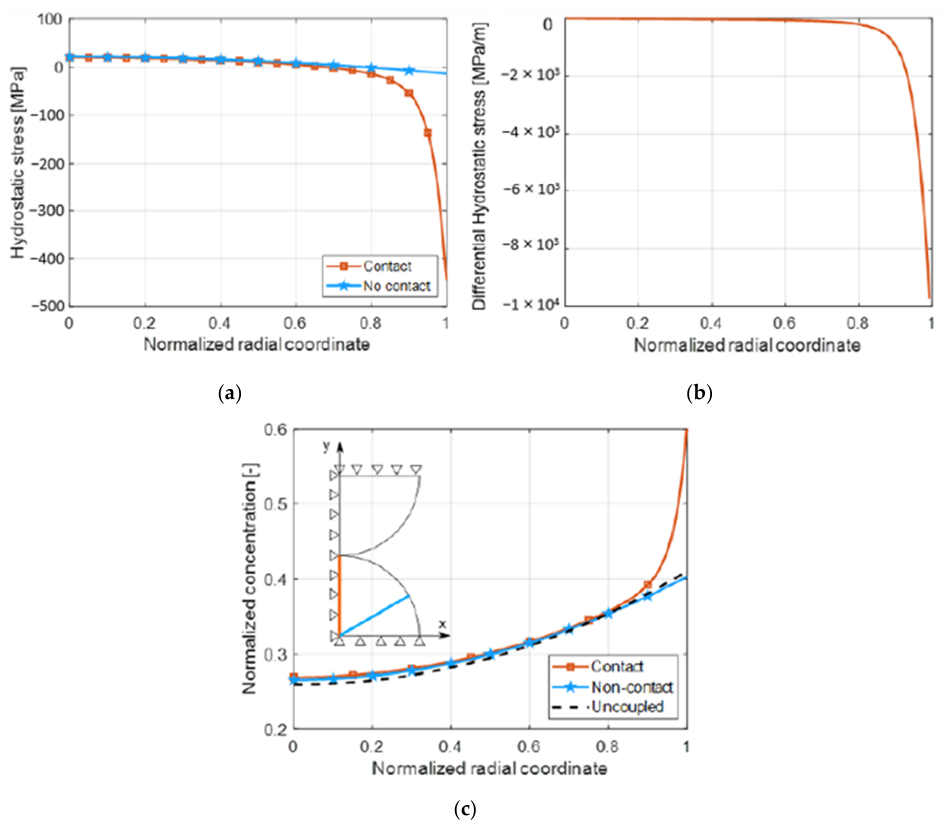
Figure 7. Hydrostatic stress ( a ) and lithium concentration ( c ) in contact (red), non-contact (blue) domains. Hydrostatic stress derivative with respect to radial coordinate in contact domain ( b ). Lithium flux 1 A/m 2 .